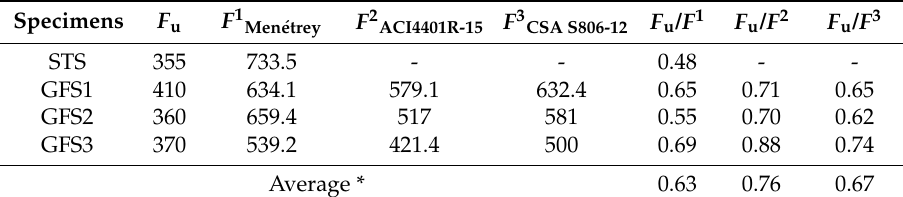
Table 5. Prediction and comparison results of tested punching shear strength.